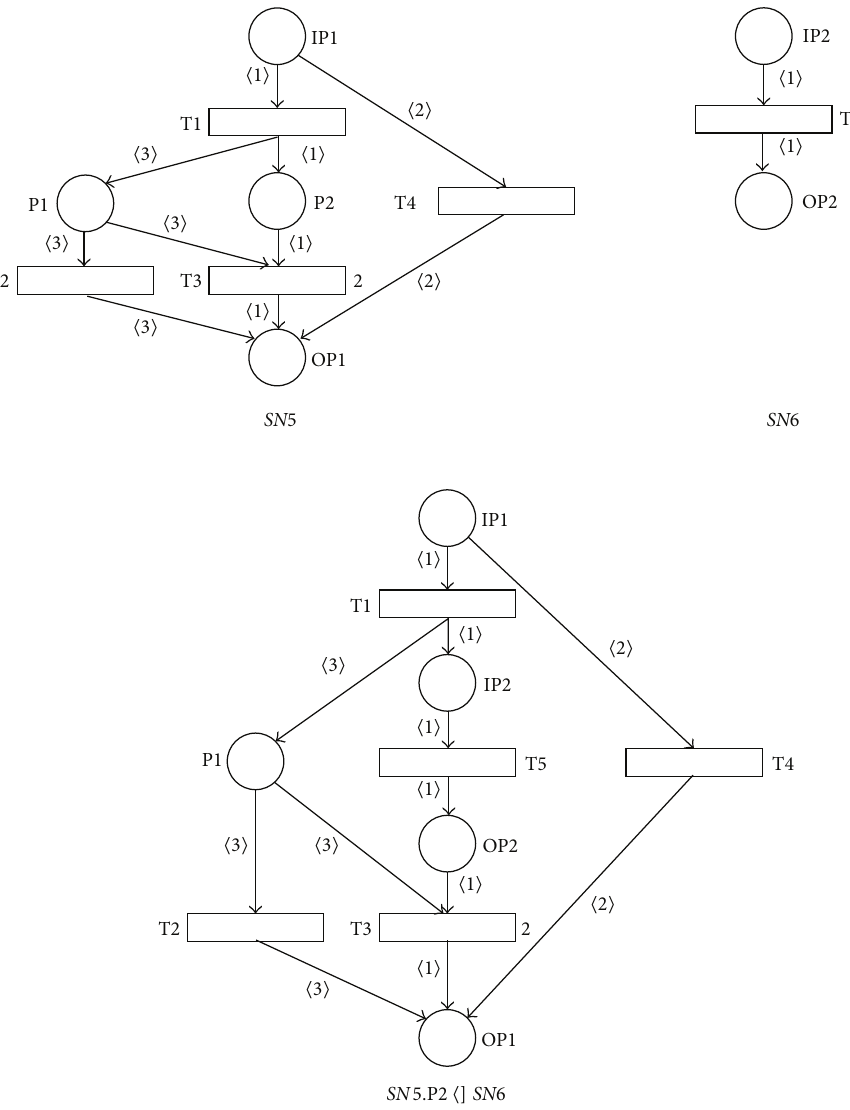
Figure 8: Result of place-substitution operation 𝑆𝑁5. P2 ⟨] 𝑆𝑁6